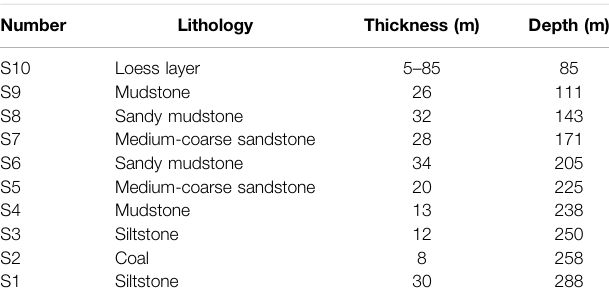
TABLE 1 | Overburden composition of the working